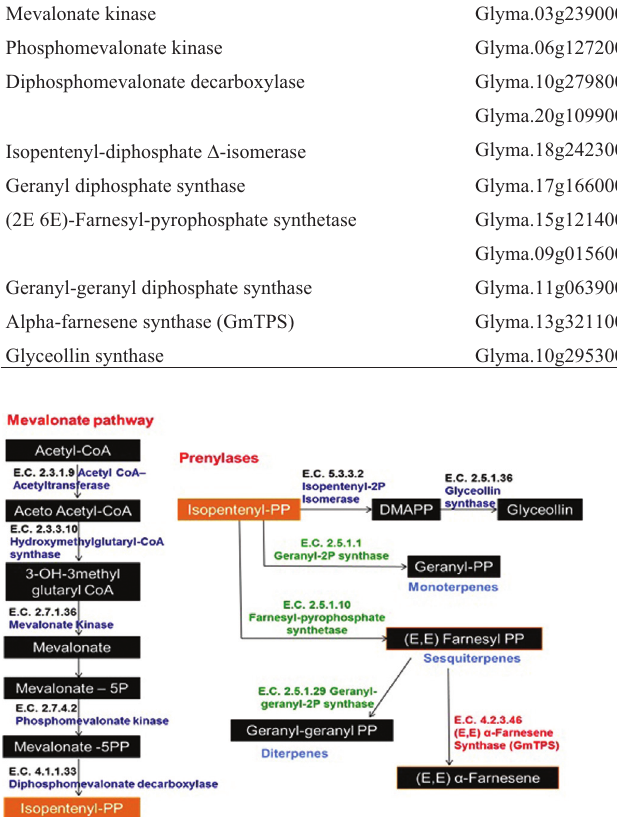
Figure 1 - Fluxogram of mevalonate pathway genes evaluated by RT- qPCR and the different terpenes formed from isopentenyl diphosphate (IPP)throughtheactionofprenylases,aswellasterpenesynthases(shown in